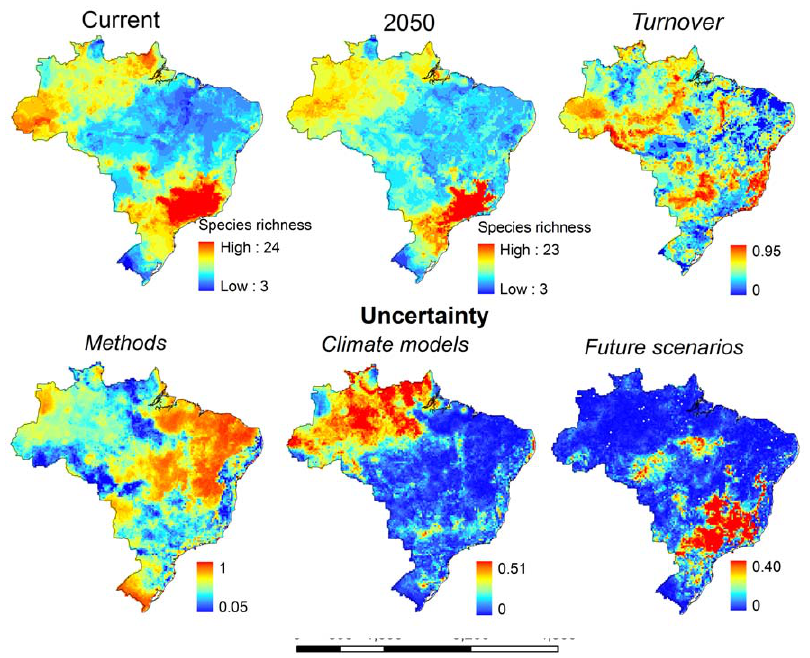
Figure 2. Consensus map of marsupial species richness in Brazil for current and future climatic conditions, mean turnover forecasted by model projections, and geographic patterns of model uncertainty arising from different sources: modeling methods, climate models, and green house gases emission scenarios. See text for further details.